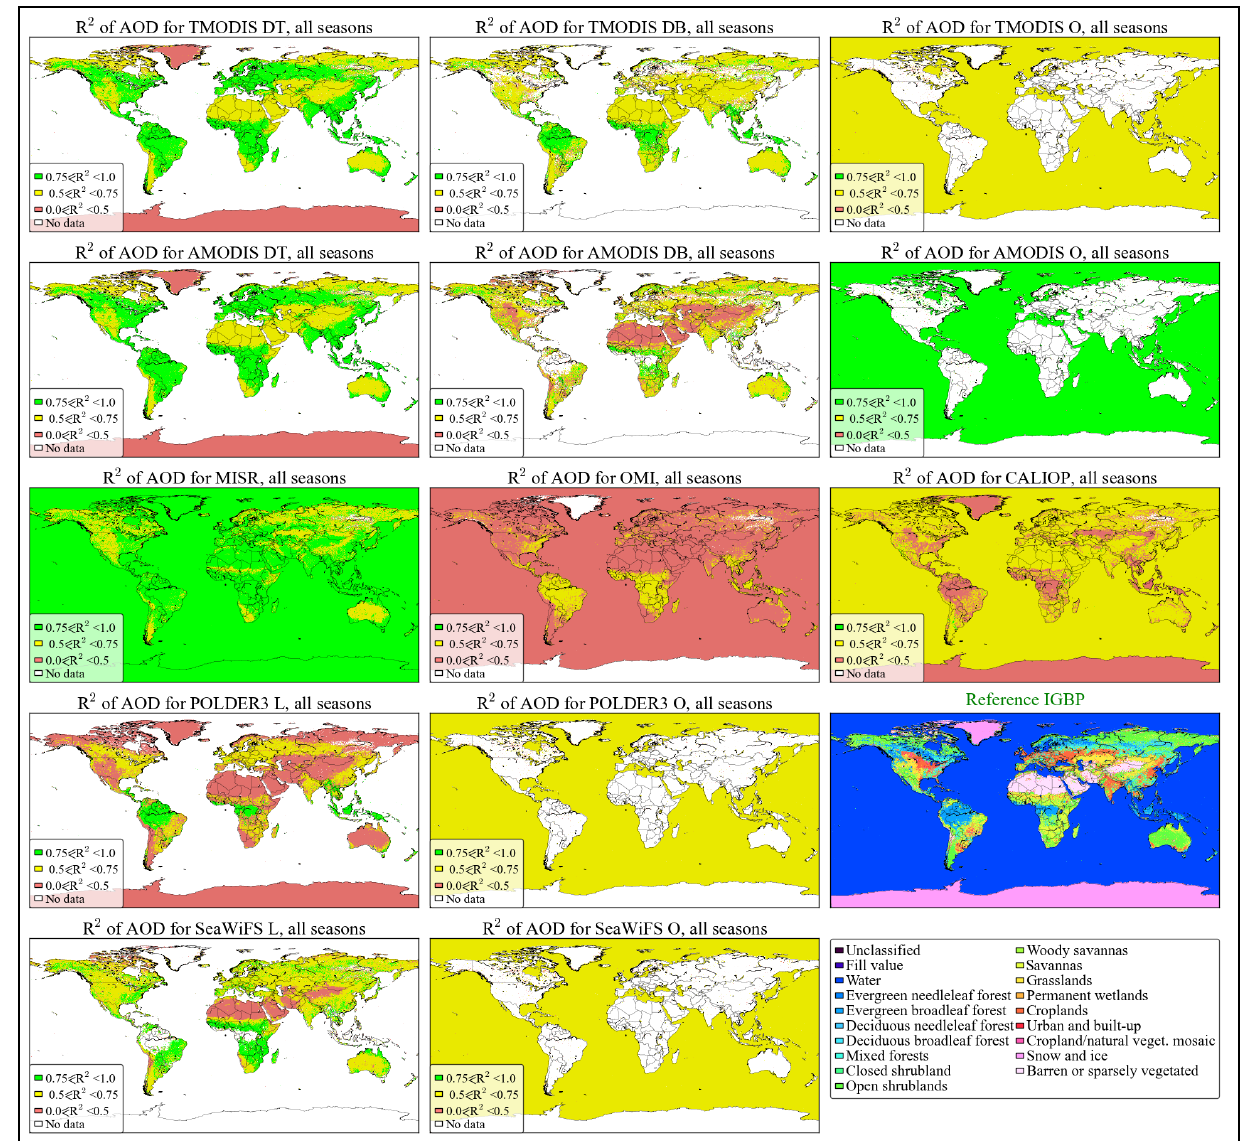
Fig. 13. Land cover type dependence of squared linear fit correlation coefficient ( R 2 ) between the collocated spaceborne and ground-based (AERONET) observations of AOD. Areas corresponding to each IGBP land cover type (bottom right inset) are colored based on the average of the data from those AERONET sites that reside in these areas. The statistics were calculated based on data that were pre-filtered by QA and screened of outliers as described in Sects. 4 and 5.